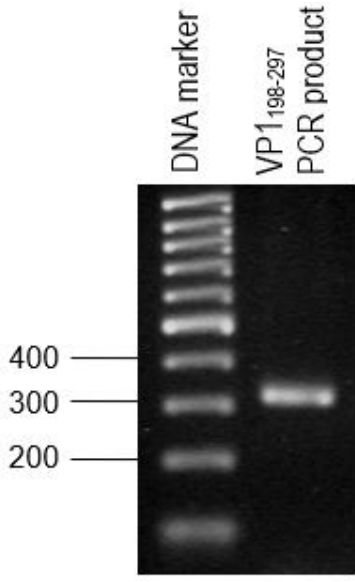
Figure 4. PCR product of VP1 198–297 gene with the size of 300 bp approximately.